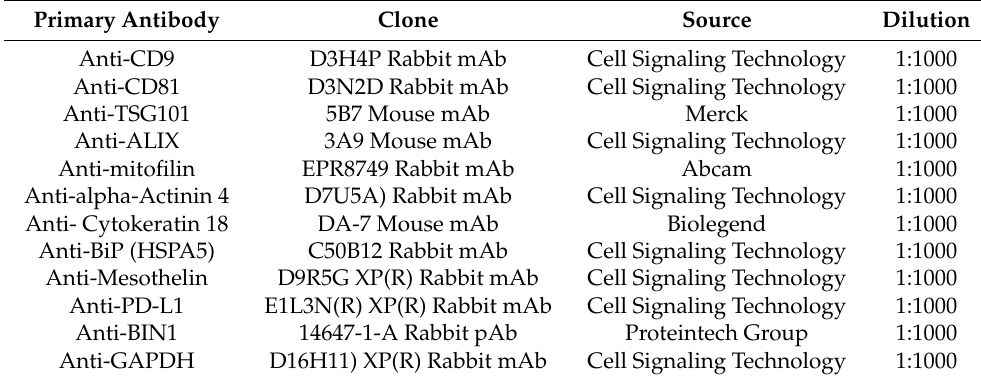
Table 2. List of primary antibodies used in this